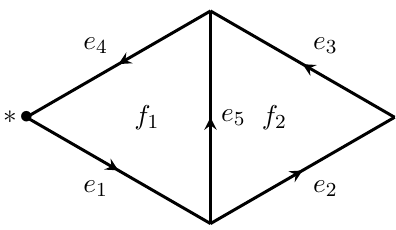
Figure 12 . Triangulation of a disc. We take ∗ and s ( e 2 ) as the base points of f 1 and f 2 , respectively. Both faces are oriented